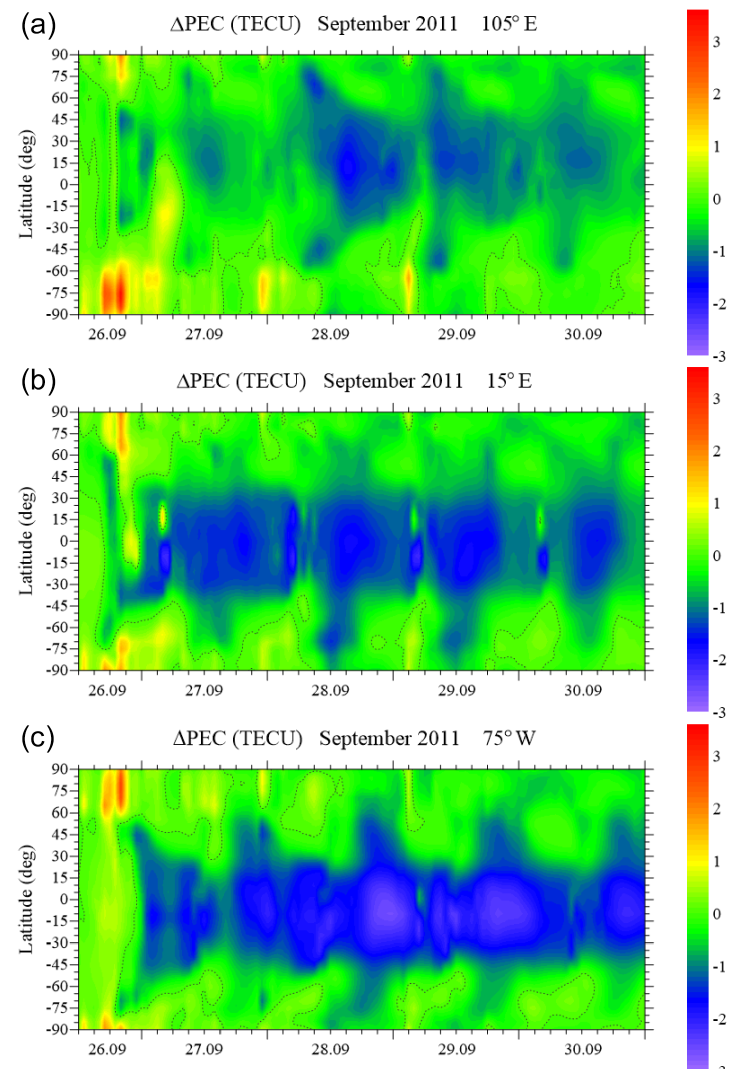
Figure 8. Behavior of the GSM TIP model-derived PEC (electron content in the altitudinal range 800–20000km) disturbances during geomagnetic storms on 26–30 September 2011 at the longitude of 105 ◦ E (a) , 15 ◦ E (b) , and 75 ◦ W (c)